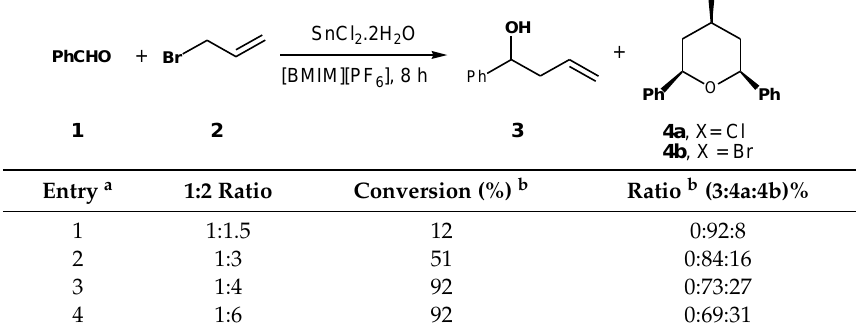
Table 1. Reaction between benzaldehyde (1) and allyl bromide (2) promoted by SnCl 2 ·2H 2 O in [BMIM][PF 6 ].